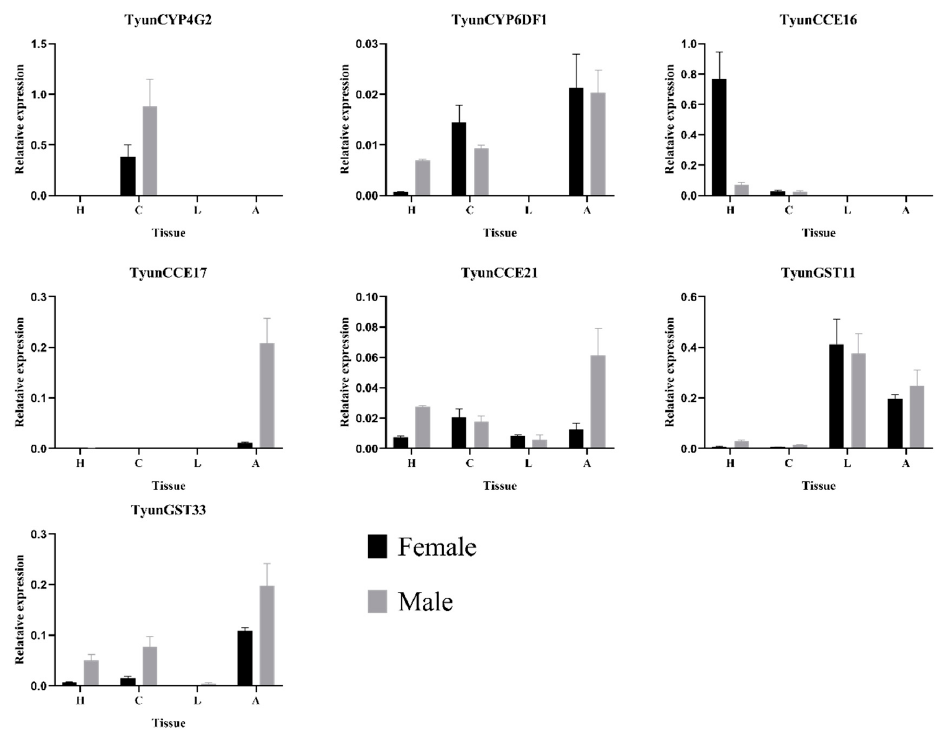
Figure 7. qPCR analysis of T. yunnanensis detoxification genes transcript levels in different tissues.